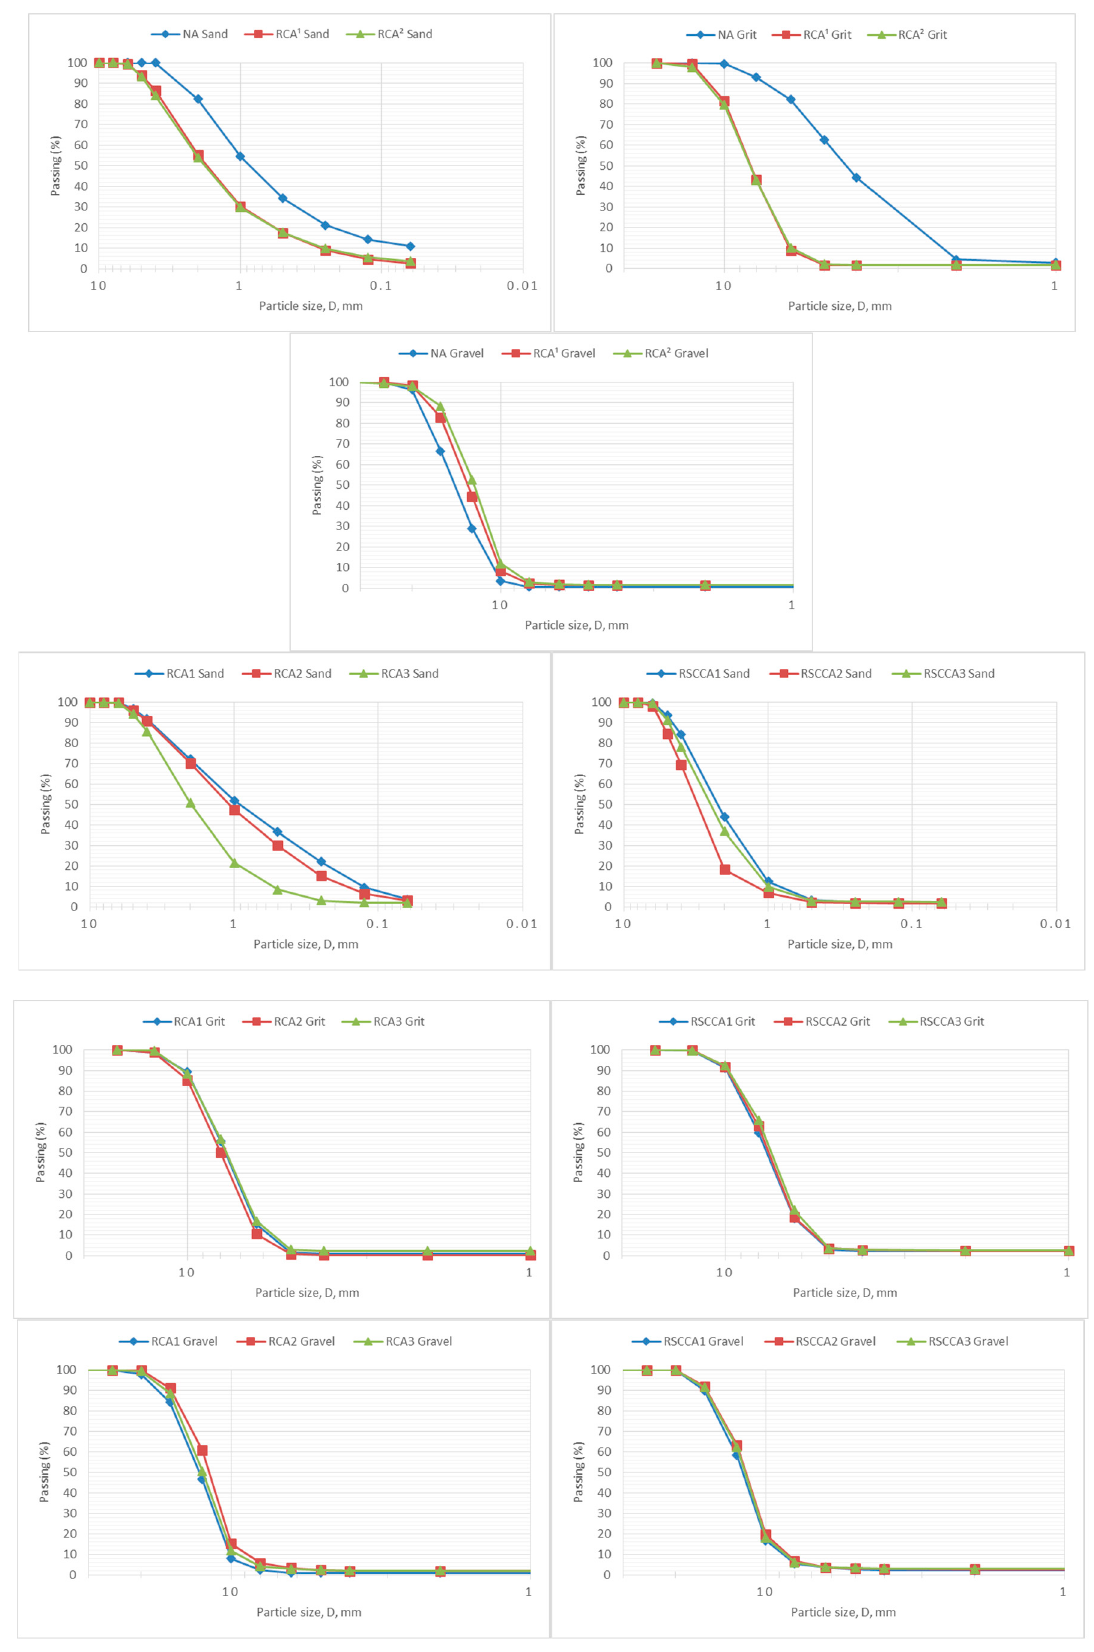
Figure 3. Particle size distribution of different analysed natural and recycled aggregates sizes. Most of the analysed coarse aggregates (grit and gravel) have a d/D ratio higher than 1.4; therefore, it can be stated that the size distribution is well-graded. Similar results were obtained in previous research [60]. There are no significant differences between the coarse sizes of the different recycling cycles, neither in recycled self-compacting concrete aggre- gates nor in recycled common concrete aggregates. Regarding the fine aggregates (sand), NA sand shows a typical S-shape distribution [36]. RCA 1 and RCA 2 sands also display an S-shape distribution but with larger particle sizes. Regarding sands of the second stage, their size distribution tends to be a bit more evenly graded than NA sand, but still well-graded. It can also be observed that with each repetition of the recycling process, a bigger particle size distribution was obtained, which is contrary to some previous research [99,100] but in accordance with other studies [55,60]. This can be explained by the high quality of parent concretes (dosage and careful manu- facturing), which causes larger sizes due to their hardness in the crushing process. Regarding the number of particles < 0.063, recycled coarse aggregates (grit and gravel) have, in general, a number of fine particles higher than 1.5% (limit value of EHE- 08); only some of the first recycled cycle aggregates have values below this limit. To meet the fine quantity specification, the coarse recycled aggregates should be washed. With each recycling cycle, the number of fine particles attached to coarse aggregates increases. However, recycled sands have values between 1.6 and 3.5, lower than 6%, which is the limit value of EHE-08. 5.2. Sand Equivalent Test The sand equivalent test shows that with each recycling cycle, the cleanliness of fine aggregates tends to be higher: the test results increase with each cycle. Between the third and second cycles, the difference is greater than between the first and second recycling cycles. In all of the recycled sands, the sand equivalent index is higher than 75, which is the minimum value for the worst concrete exposure classes, according to EHE-08. Moreover, the obtained results allow the use of recycled sands as graded aggregate, cement-bound gravel and cement–soil, according to the limit of > 40 by PG-3. Considering the above, it